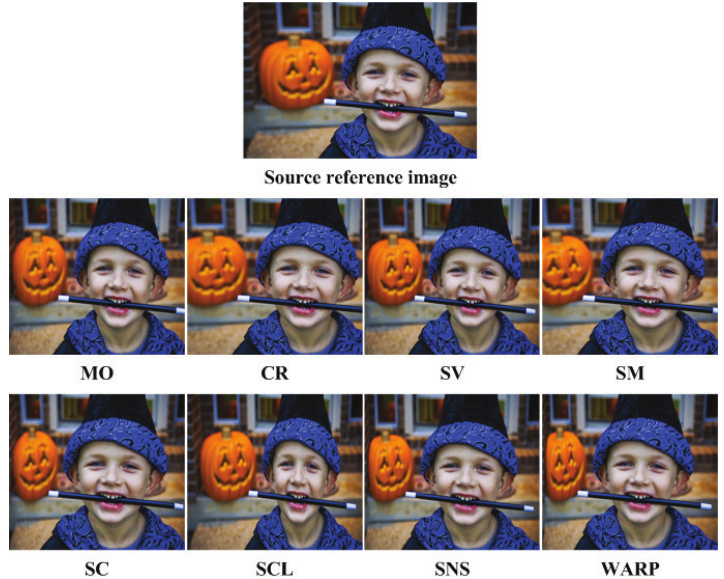
Figure 2. An example of a source reference image and eight retargeted images with different models.